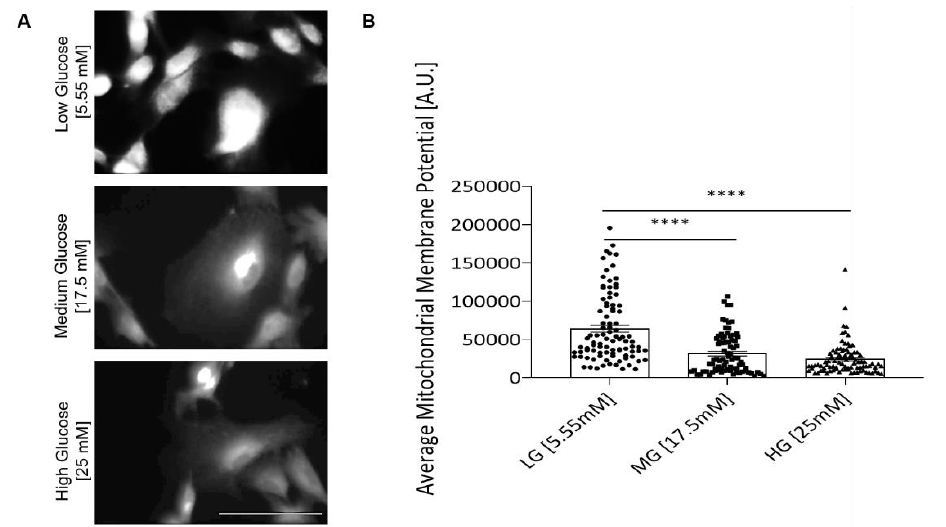
Figure 6. TMRE analysis of myoblasts grown under different glucose conditions. ( A ) Representative confocal images of TMRE staining in each D-glucose condition. ( B ) TMRE staining quantification for inner mitochondrial membrane potential of iPSC-derived myoblasts in euglycemic versus hy- perglycemic conditions. Four coverslips from two experiments were quantified for each glucose condition. Error bars = SEM. P ≤ 0.1, *; P ≤ 0.05, **; P ≤ 0.01, *** , P ≤ 0.001, ****. Statistics was performed utilizing One-way ANOVA with post-hoc Tukey HSD Test.